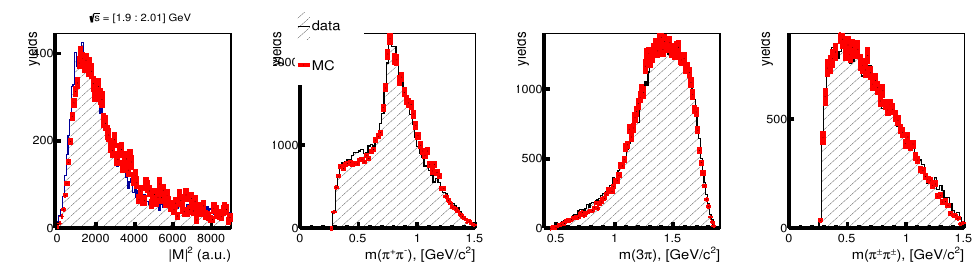
Figure 5. The data-MC comparison of the squared matrix element | M | 2 and π + π − , 2 π ± π ∓ and π ± π ± mass spectra for the process e + e − → 2 π + 2 π − for the energy ranges